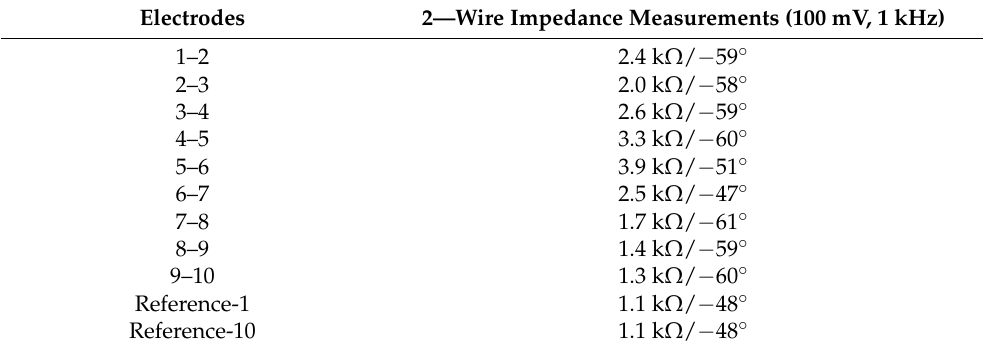
Table 3. Two-wire impedance measurements of the electrodes as dipoles for an implanted cuff in sheep .